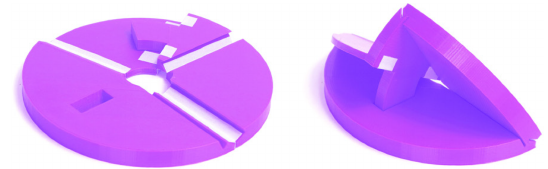
Figure 23. Tabbed sector panel ThUDS with tab lock groove and panel contact. Shown in flat and deployed